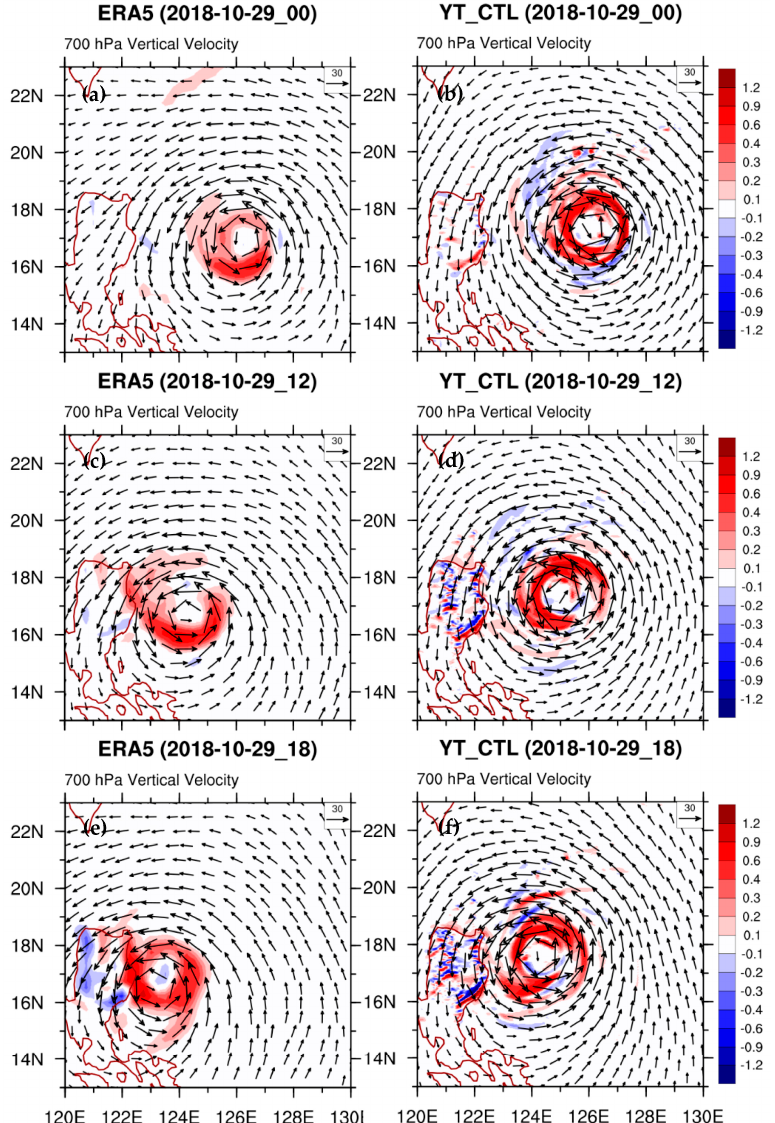
Figure 12. Simulated horizontal wind (wind vectors; m s − 1 ) and vertical velocity (shaded colors in m s − 1 ) at 700 hPa for ( a ) ERA5 and ( b ) YT-CTL at 0000 UTC 29 October. ( c ) and ( d ) are the same as in ( a ) and ( b ), respectively, but at 1200 UTC 29 October. ( e ) and ( f ) are the same as in ( a ) and ( b ), respectively, but at 1800 UTC 29 October.